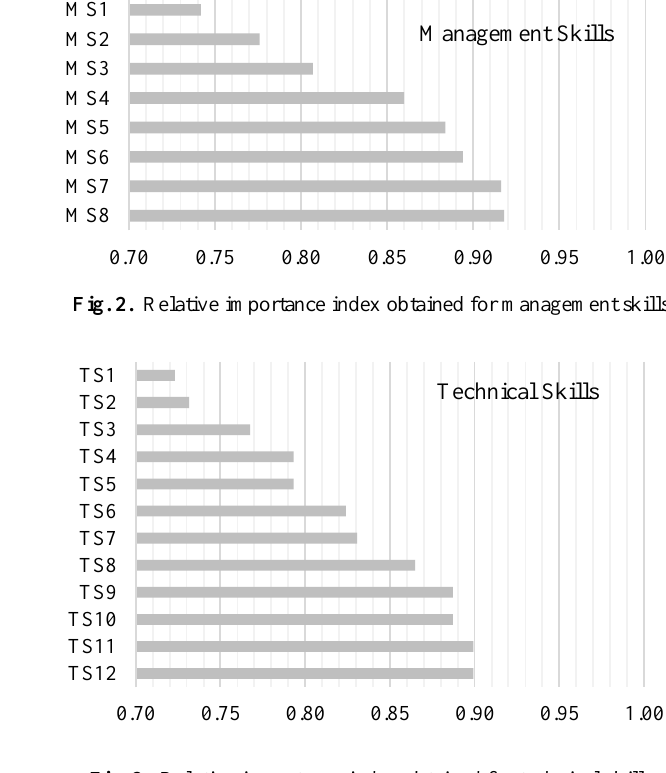
Fig. 3. Relative importance index obtained for technical skills